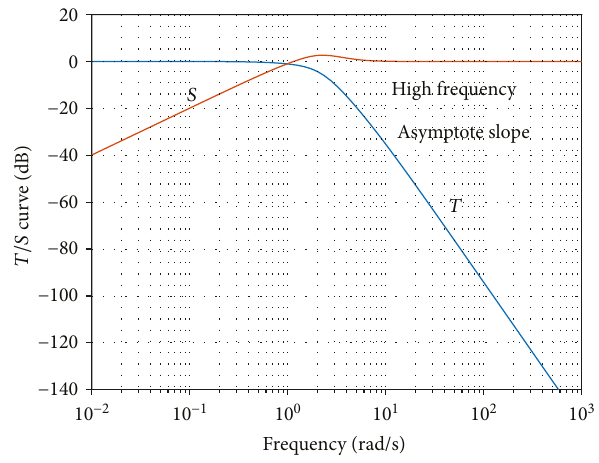
Figure 7: S & T singular value curves.